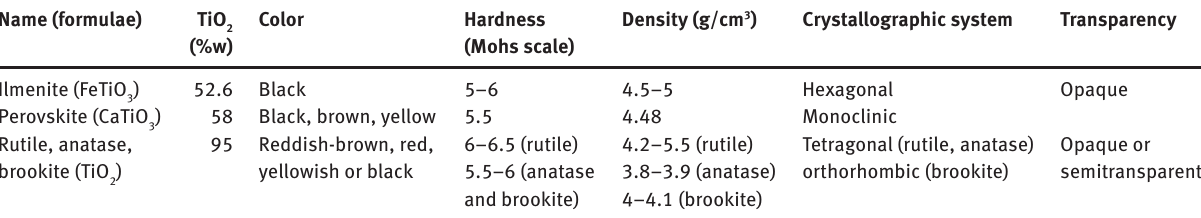
Table 1: Properties of some mineral of titanium.